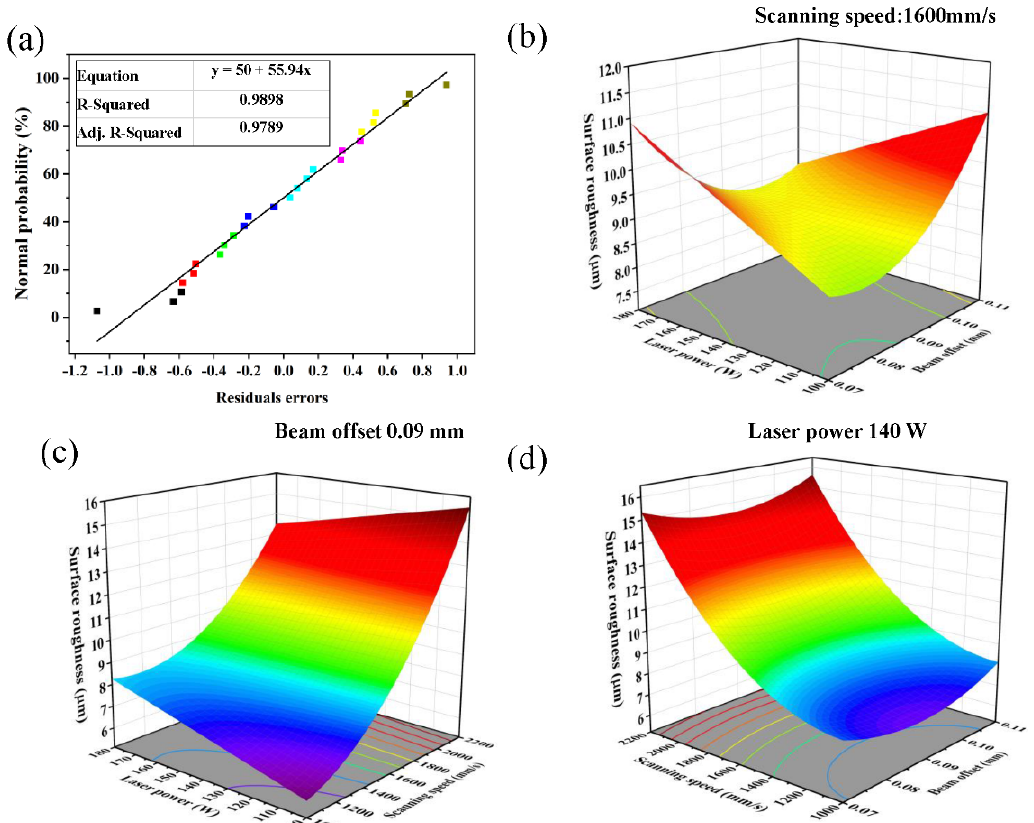
Figure 6. ( a ) Probability distribution of residuals. Response surface showing the effect of the variables on surface roughness: ( b ) Laser power and beam offset, ( c ) Laser power and scanning speed, ( d ) Scanning speed and beam offset.